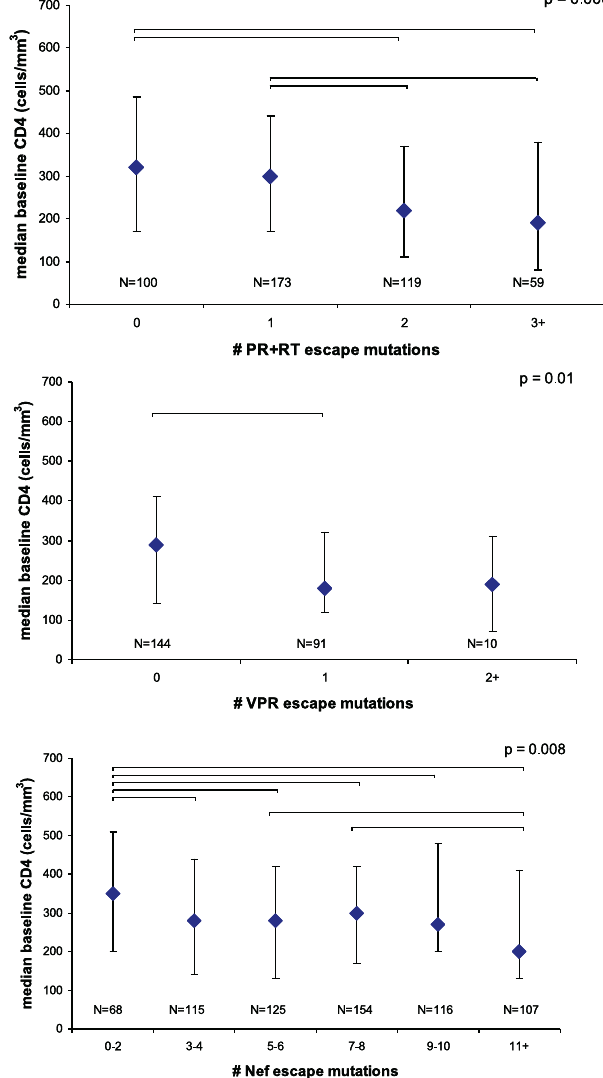
Figure 7. Inverse Dose-Response Relationship between Accumulation of Epitope-Associated Escape Mutations in Protease/Reverse Transcriptase, Vpr, and Nef and CD4 þ Cell Count in Chronic Untreated HIV Infection A significant inverse dose-response relationship is observed between the presence of epitope-associated escape mutations in protease/RT (A), Vpr (B), and Nef (C) and CD4 þ cell count in chronic untreated HIV infection. Escape mutations were defined as all significant HLA/HIV associations which mapped within or proximal to ( 6 3 aa) known CTL-restricted epitopes (listed in Figures 2 and 3). Analysis was restricted to participants able to exhibit ‘‘ escape, ’’ i.e., those possessing at least one HLA allele featured in Figures 2 and 3 (for each gene investigated). Linked alleles were removed to avoid double counting of associations. Diamonds and bars represent median and interquartile ranges, respectively, of pretherapy CD4 þ cell count for each of the associated escape strata. Overall p -value obtained using the Kruskal-Wallis test. Significant ( p , 0.05) pairwise associations are indicated by brackets.